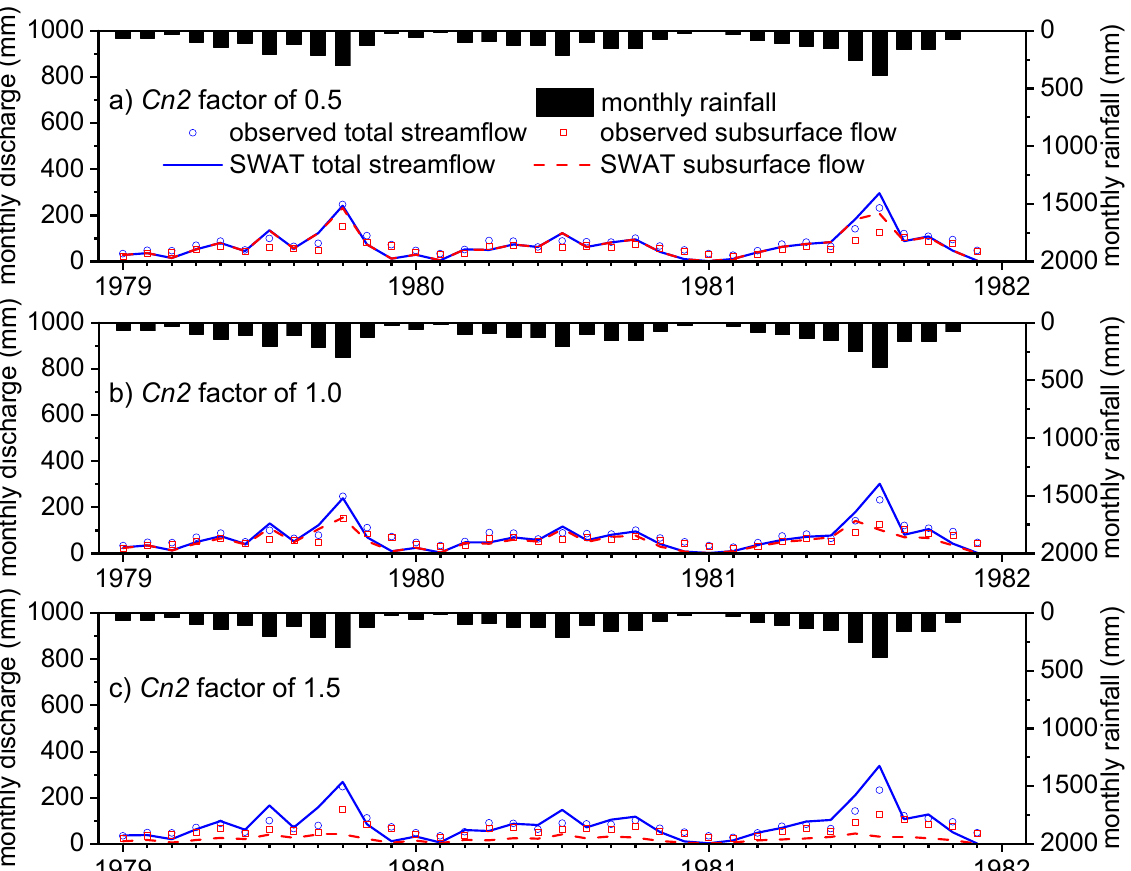
Figure 9. Monthly total and subsurface flow hydrographs from 1979 to 1981 at varying Cn2 factors: ( a ) 0.5, ( b ) 1.0, and ( c ) 1.5.